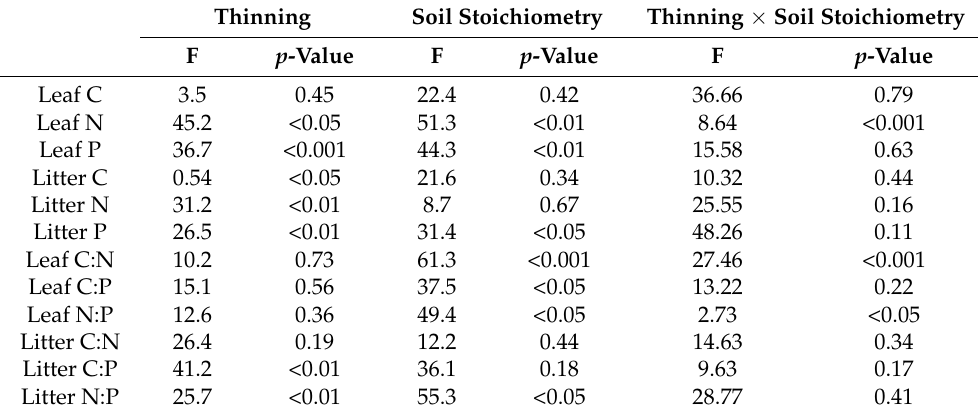
Table 3. F and P values for the effects of thinning and soil stoichiometry on plant and soil C:N:P stoichiometric characteristics in a Pinus massoniana forest plantation. The soil stoichiometry refers to the same element as that in a given row.